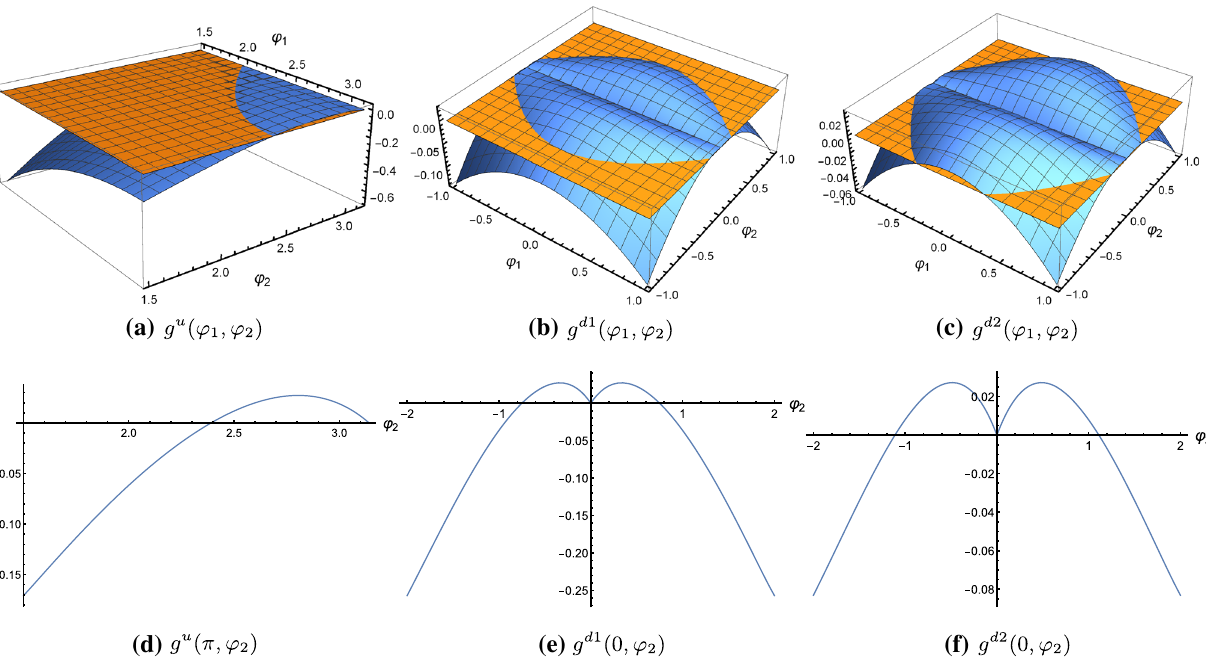
Fig. 2 LI violation of entangled B d mesons. θ s is fixed to be sin − 1 0 . 695.OurLIisviolatedwhen g u (ϕ 1 ,ϕ 2 ) > 0or g d 1 (ϕ 1 ,ϕ 2 ) > 0 or g d 2 (ϕ 1 ,ϕ 2 ) > 0. g u > 0 when ϕ 1 = π , 2 . 39 < | ϕ 2 | < π , and the maximum is at ϕ 1 = ± π,ϕ 2 ≈ ± 2 . 81. g d 1 > 0 when ϕ 1 = 0,